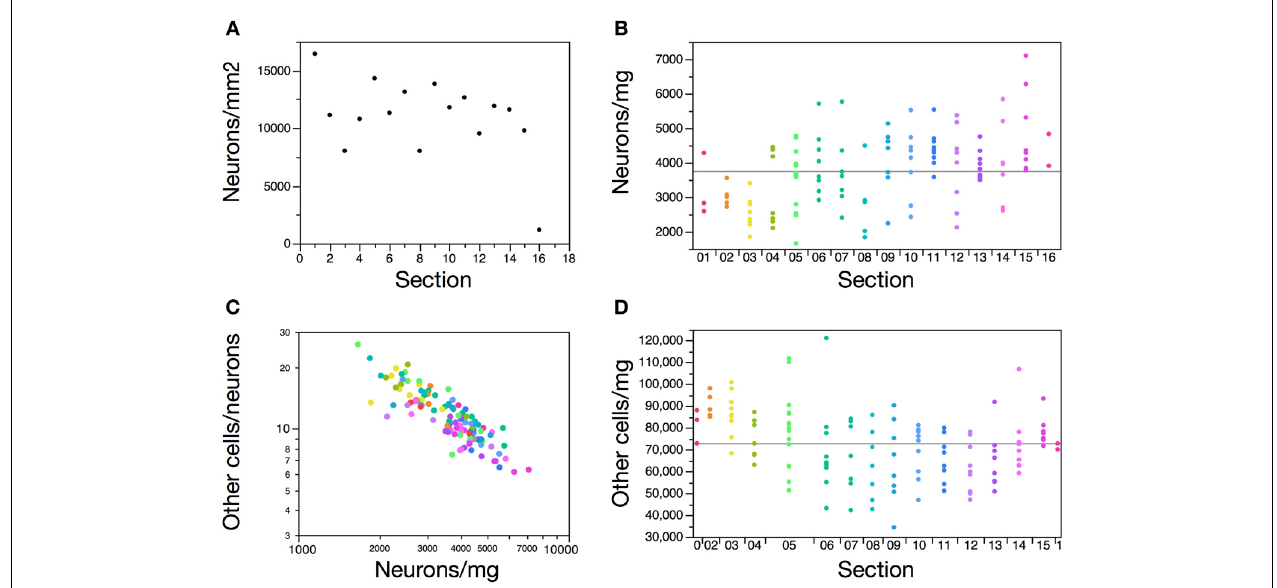
FIGURE 3 | Distribution of neurons along the anteroposterior axis of the elephant cerebral cortex. (A) Average number of neurons under 1mm 2 of cerebral cortical surface varies randomly along the 16 coronal sections along the anteroposterior axis. Frontal pole is section 1. (B) Neuronal density in the cortical gray matter varies along the anteroposterior axis, with smaller neuronal densities in anterior sections 2–5 than in the remainder of the cortex. Each data point represents